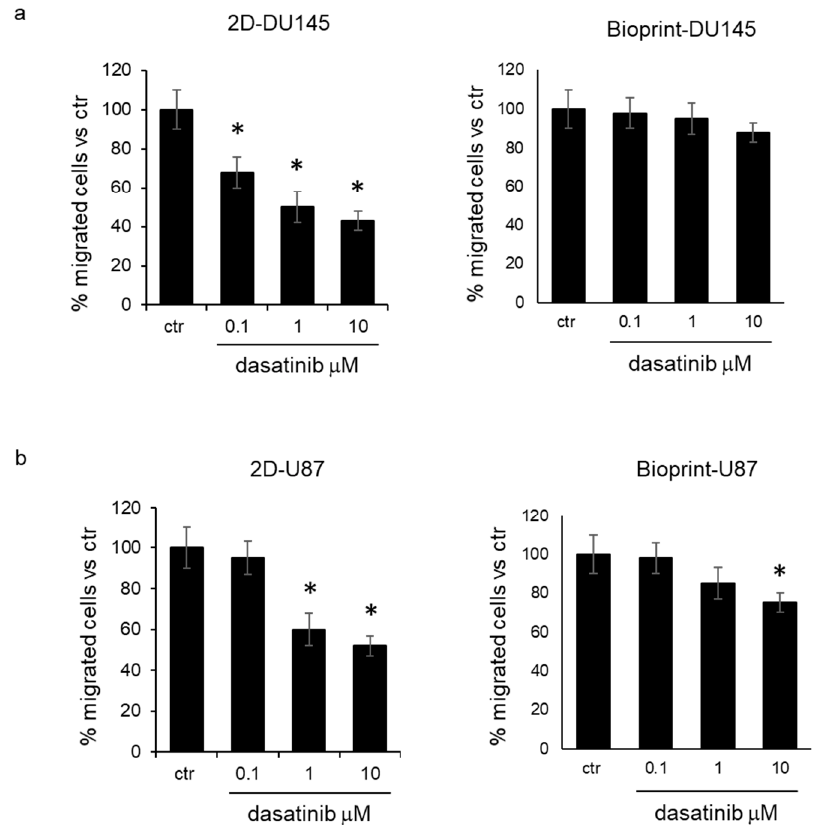
Figure 4. Inhibition of cell migration by dasatinib. ( a ) Percentage of migrated DU145 cells evaluated in transwell system utilizing cells from standard cell culture (2D, left ) or from bioprint model ( right ) and treated for 24 h with increasing concentrations of dasatinib (0.1, 1, and 10 µ M). The mean values measured in untreated cells were adjusted at 100%. Each value represents the mean of five different measurements (±standard deviation). * p < 0.01 vs. ctr, according to Student’s t test. ( b ) Percentage of migrated U87 cells evaluated in transwell system utilizing cells from standard cell culture (2D, left) or from bioprint model (right) and treated for 24 h with increasing concentrations of dasatinib (0.1, 1, and 10 μ M). The mean values measured in untreated cells were adjusted at 100%. Each value represents the mean of five different measurements (±standard deviation). * p < 0.01 vs. ctr, according to Student’s t test.